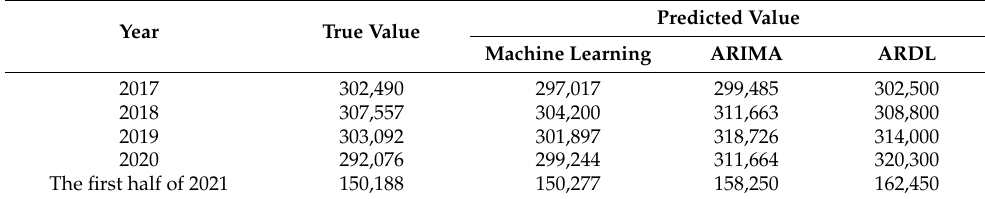
Table 6. Predicted value of ML, ARIMA, and ARDL. Unit: 1000